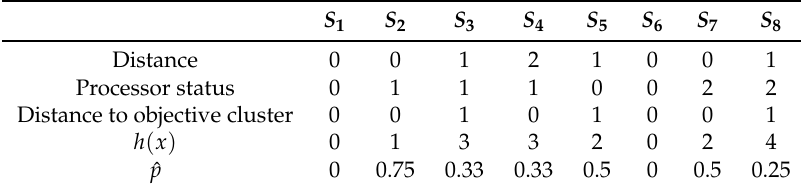
Table 6. Initial population. A first set of evaluation results for each parameter.